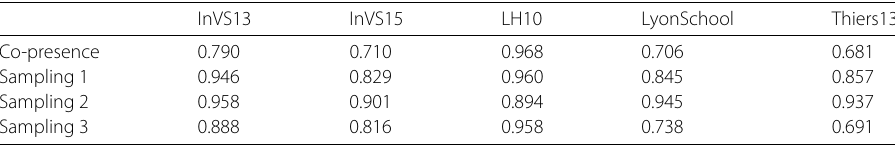
Table 2 Similarity between contact matrices InVS13 InVS15 LH10 LyonSchool Thiers13 Co-presence 0.790 0.710 0.968 0.706